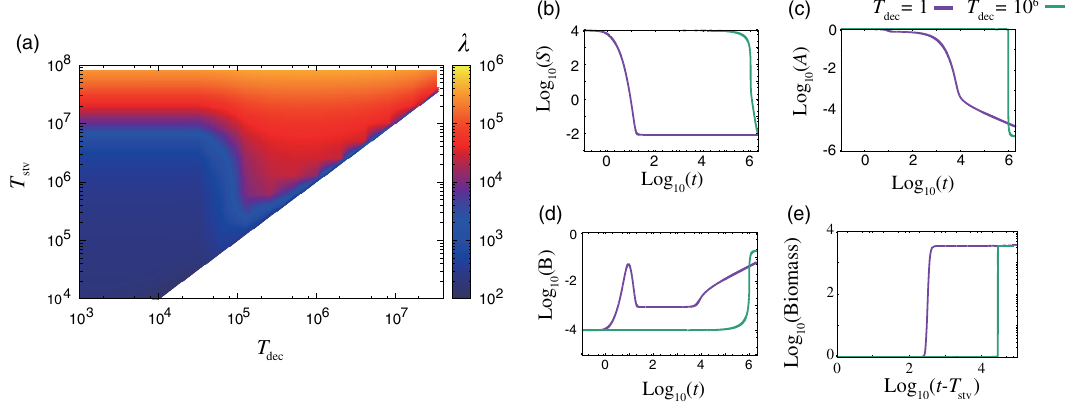
FIG. 3. (a) Dependence of lag time λ on the time required to decrease the substrate T and starvation time T . (b – d) Time series of dec stv 10 6 (green line) and T 1 . 0 (purple line)] values — the internal concentrations of substrate S (b), starvation for different T [ T dec dec ¼ dec ¼ component A (c), and component B (d). (e) Time series of biomass during resurrection. The same parameter values as indicated in Fig. 2 were adopted. The batch culture model (which is used to compute a bacterial growth curve) was adopted to compute the time series of biomass accumulation (e). The time series of μ is shown in Fig. S3 of Ref.